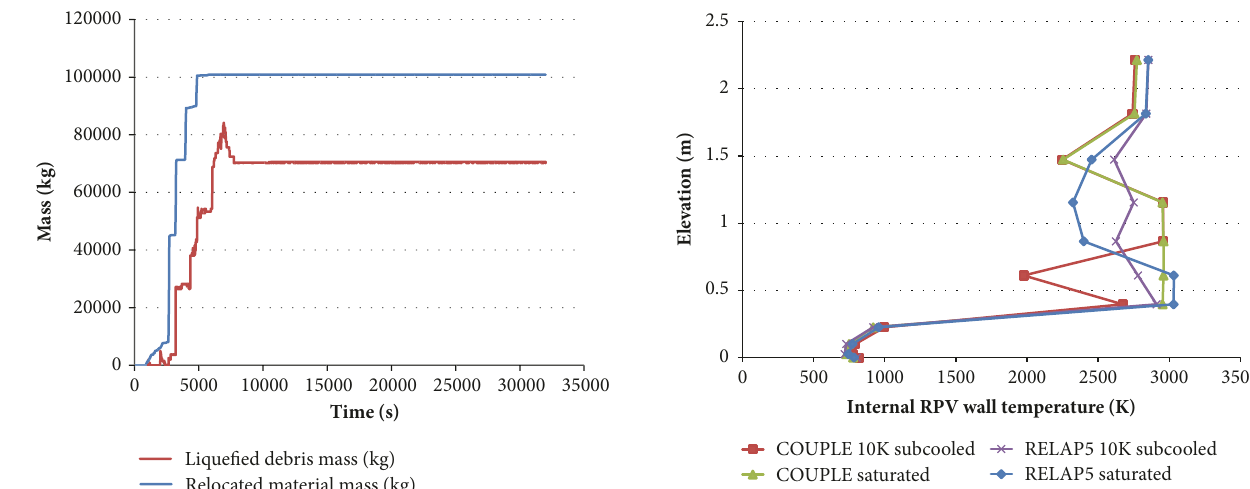
Figure 11: Liquefied debris mass in comparison with the total relocated material mass.